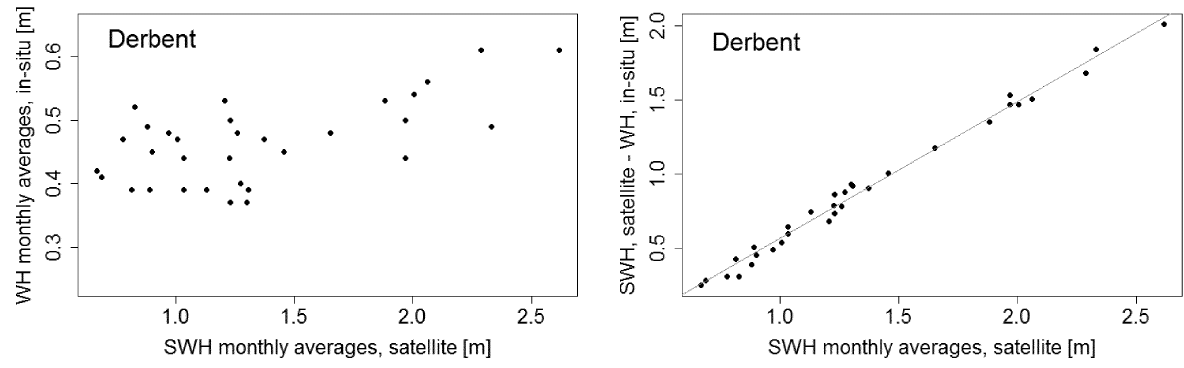
Fig. 5. Comparison of in situ and JASON-1 monthly averaged significant wave heights (SWH) for the Derbent site (left) and the difference between satellite-derived and in situ wave heights (WH) ,sat S in situ H H  and ,sat S H from satellites (right). The solid line shows a fitted regression line (Table